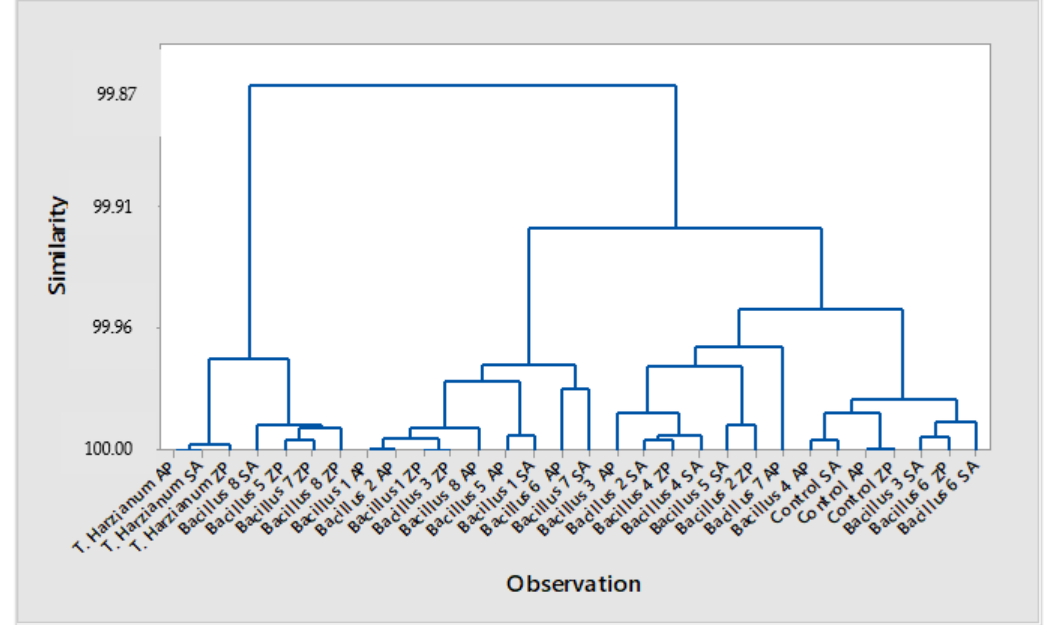
Figure 3. Cluster analysis for the treatment effect on germination, presence of fungal species Fusarium sp., Alternaria sp., Plants 2021 , 10 , x FOR PEER REVIEW Penicillium sp., Mucor sp., and on the shoot and root length, AP—Apicol, SA—Salazar, ZP—Zemunska rosa.